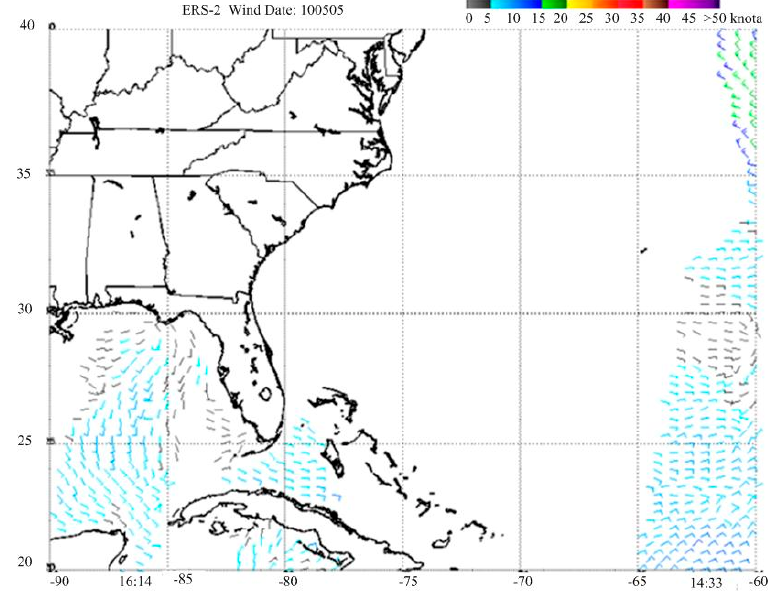
Figure 23. Wind image of Gulf of Mexico on 6 May 2010.